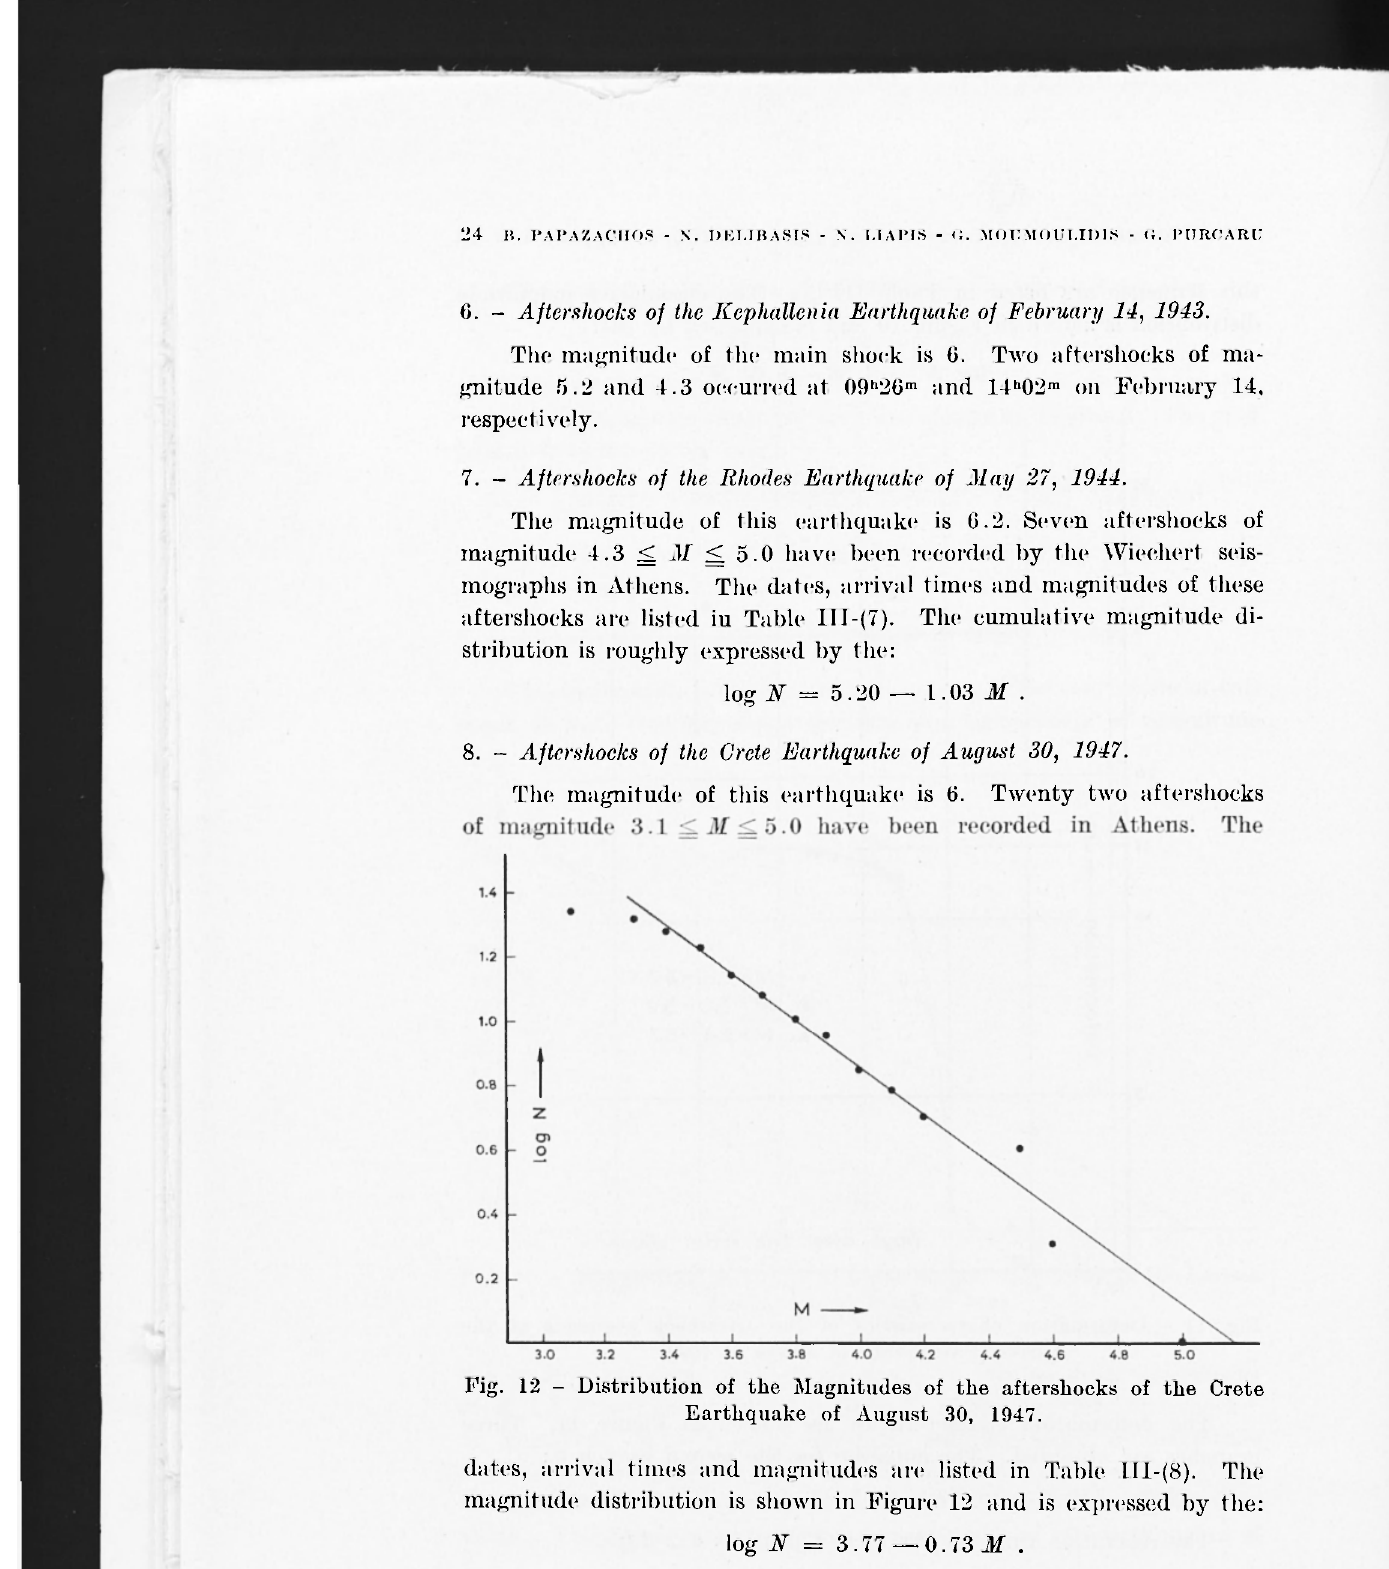
Fig. 12 - Distribution of the Magnitudes of the aftershocks of the Crete Earthquake of August 30,